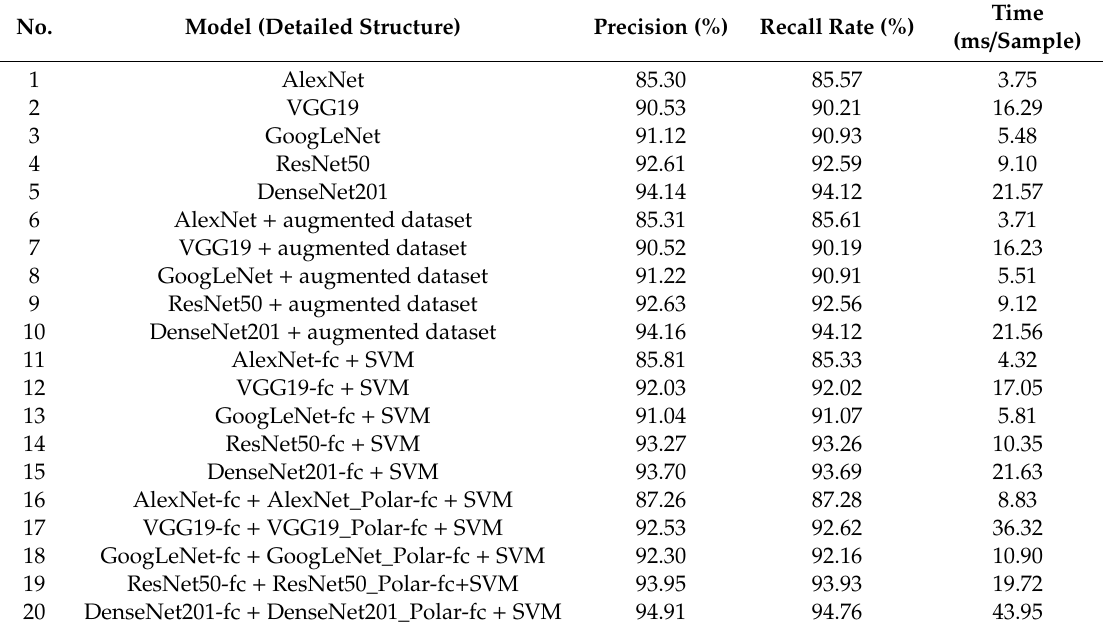
Table 2. Performances of di ff erent models with respect to the CIFAR-10